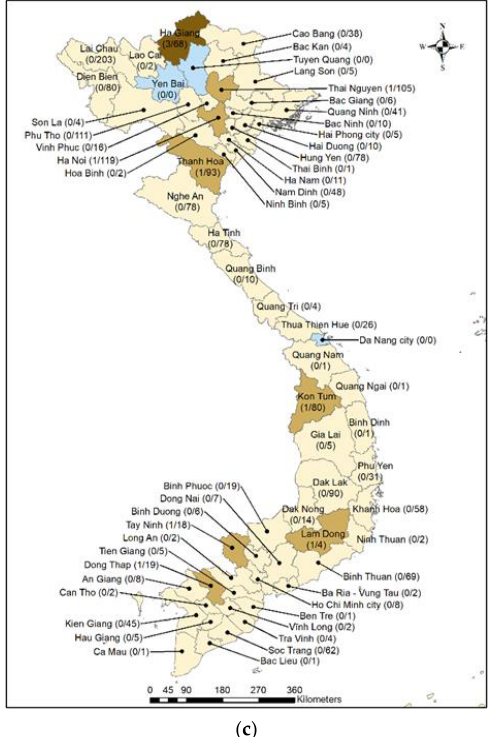
Figure 4. Distribution of confirmed cases of: ( a ) Scrub Typhus, n = 484; ( b ) Murine Typhus, n = 67; and ( c ) Spotted Fever, n = 10 ( c ) by provinces. The color density corresponds to the number of confirmed cases: the darker the color, the higher the number of confirmed cases. The fraction shows the number of confirmed case (numerator) and the number of recruited patients (denominator) for each province.